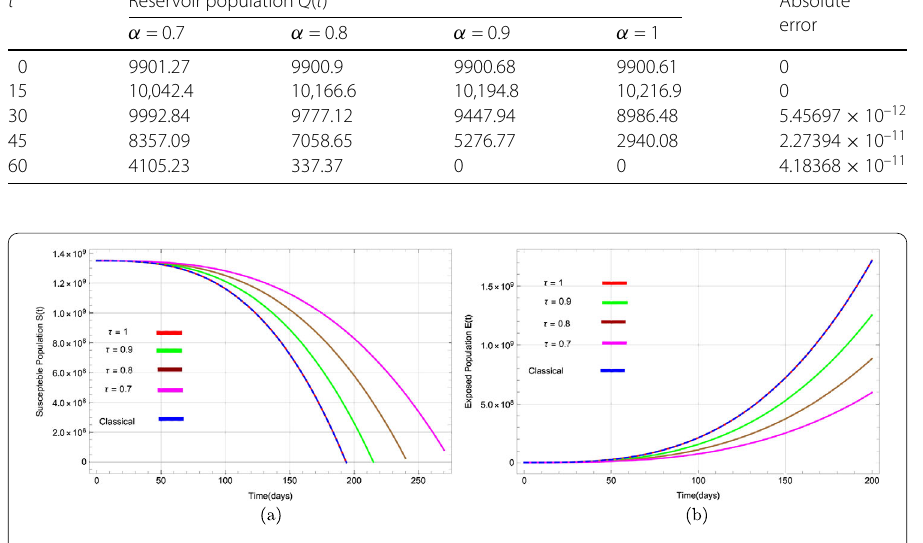
Figure 3 Dynamical behavior of ( a ) suspected population S ( t ) and ( b ) exposed population E ( t ) for various values of τ with respect to time (days)